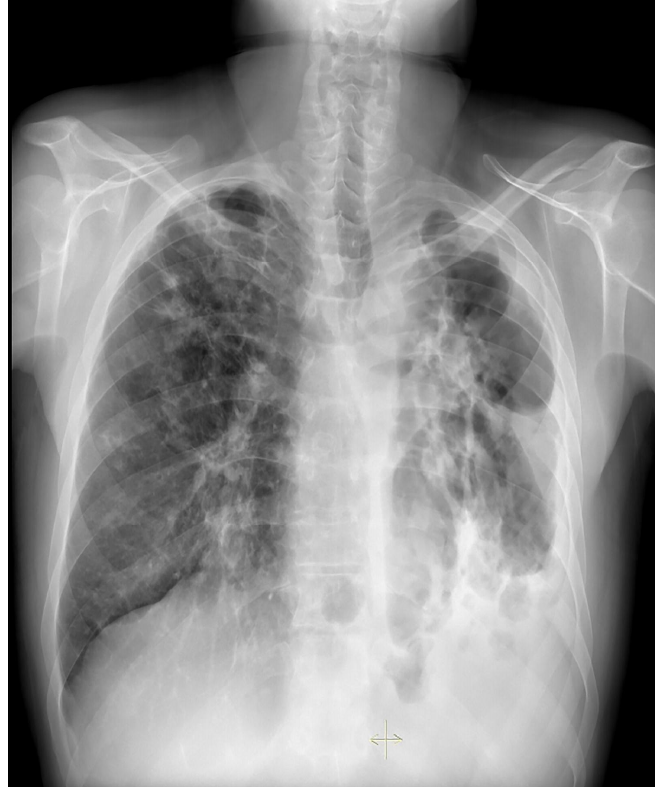
Medicina 2023 , 59 , 246 Figure 1. Case 4, beginning of the treatment. Figure 1. Case 4, beginning of the treatment.